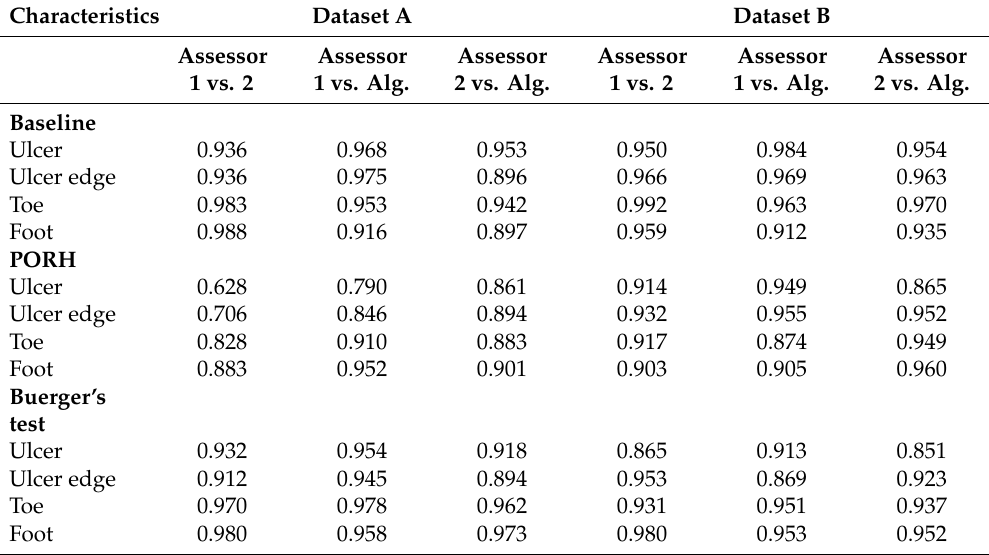
Table 1. Intraclass Correlation Coe ffi cients (ICC) of assessment of Laser Speckle Contrast Imaging with two Regions of Interest placements before baseline and Buerger’s test